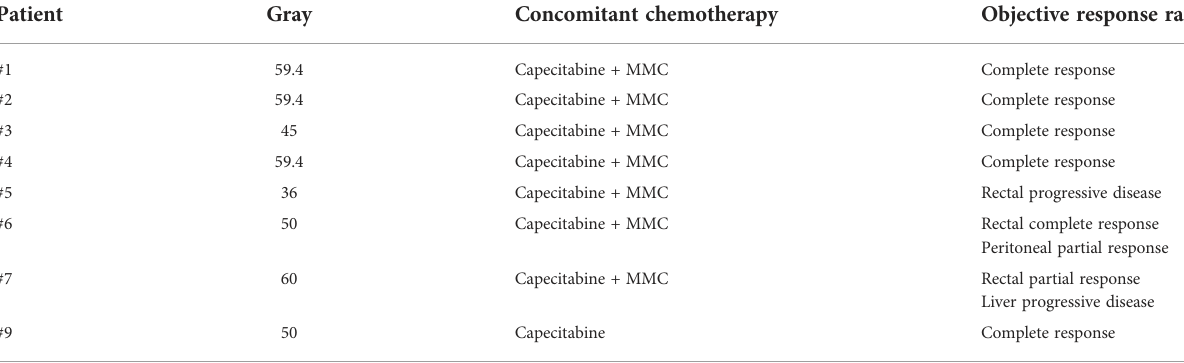
TABLE 6 Chemoradiotherapy modalities after mDCF neoadjuvant treatment in patients with rectal squamous cell carcinoma. Patient Gray